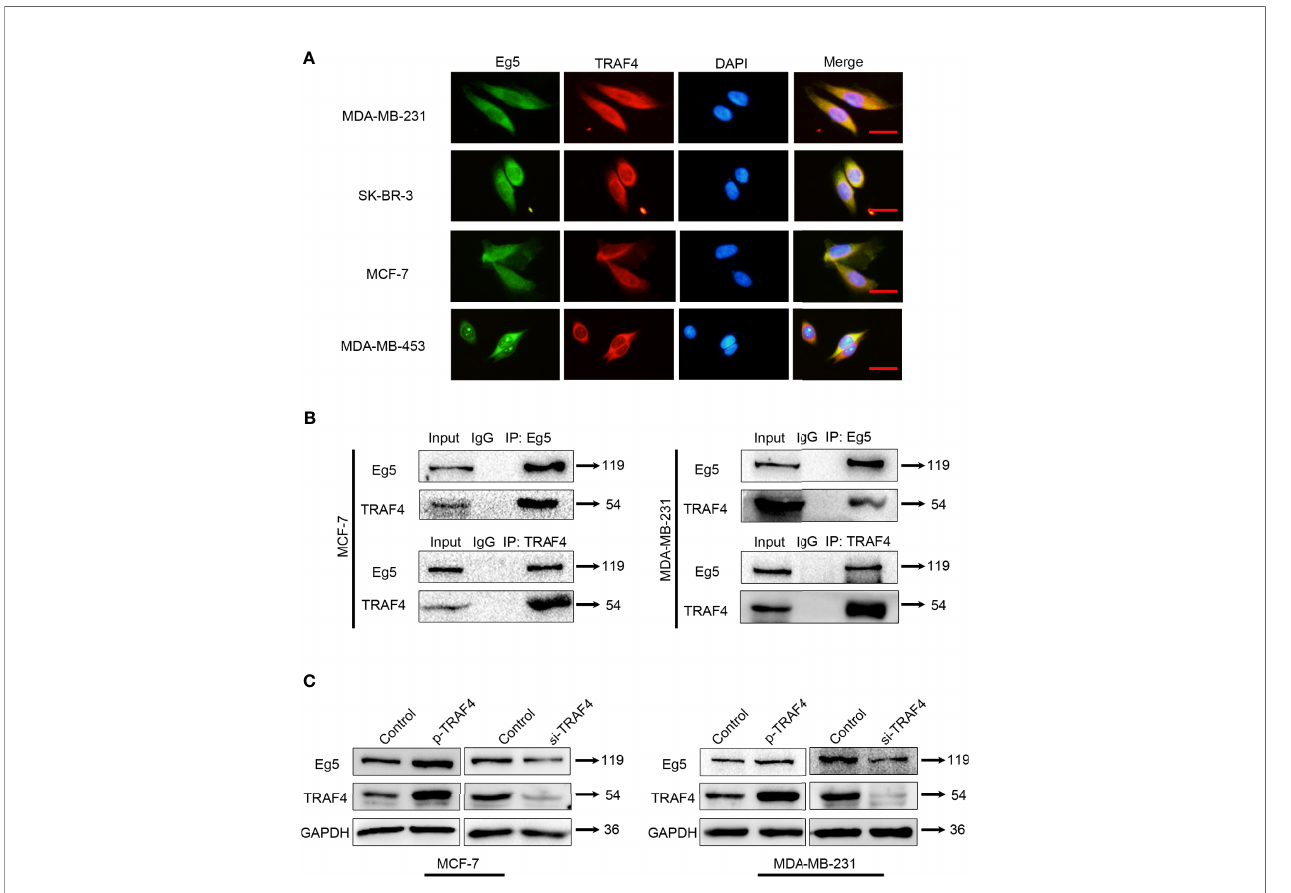
FIGURE 2 | TRAF4 interacts with Eg5 and up-regulates the protein level of Eg5. (A) Immuno fl uorescence assays demonstrated the distribution of endogenous Eg5 and TRAF4 using antibodies against TRAF4 (red) and Eg5 (green). Cell nuclei were stained by DAPI. Bar, 50 m m. (B) TRAF4 interacted with Eg5. Co-immunoprecipitation assays were performed on MCF-7and MDA-MB-231 cell lysates using antibodies against TRAF4 or Eg5, followed by immunoblotting. (C) TRAF4 up-regulated Eg5 protein levels. Proteins were extracted from cells transfected with TRAF4 protein level vector or TRAF4 si-RNA.Western blot assays were used to demonstrate the protein level of TRAF4 and Eg5. GAPDH was used as an internal